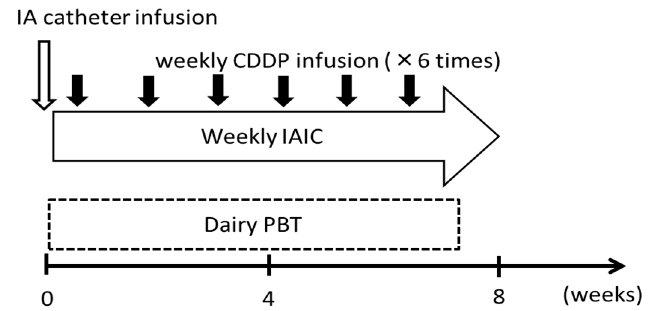
Figure 4. Treatment schedule. IA, intra-arterial; CDDP, cisplatin (20–40 mg/m 2 ); IAIC, intra-arterial infusion chemotherapy; PBT, proton-beam therapy.